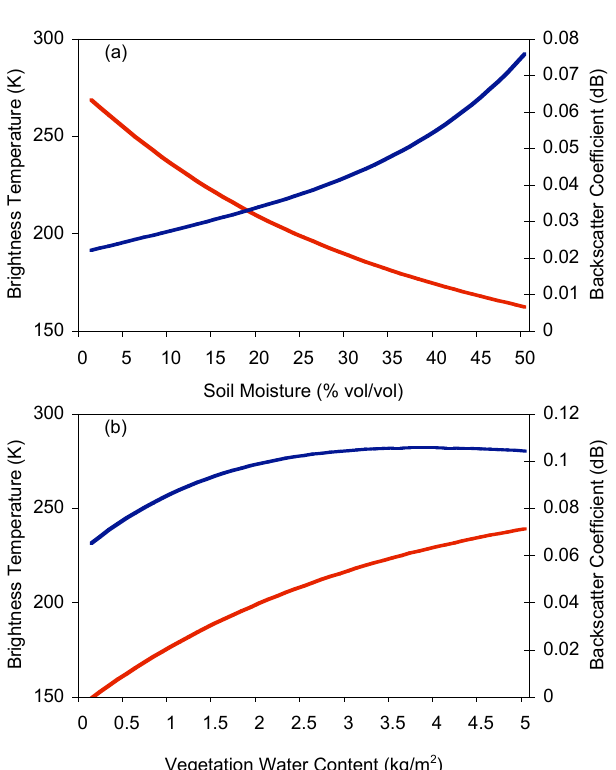
Fig. 5. The variations of synthetic observations of brightness tem- perature (K, red line) and backscattering coefficient (dB, blue line) at 38 ◦ incidence angle with H polarization in relation to (a) soil moisture (% vol/vol) and (b) vegetation water content (kgm − 2 ) over clay soil covered with evergreen needleleaf/broadleaf. Soil temperature and vegetation temperature are set to be 300K; veg- etation water content is 0.5kgm − 2 in (a) , and soil moisture is 3% vol/vol in (b).